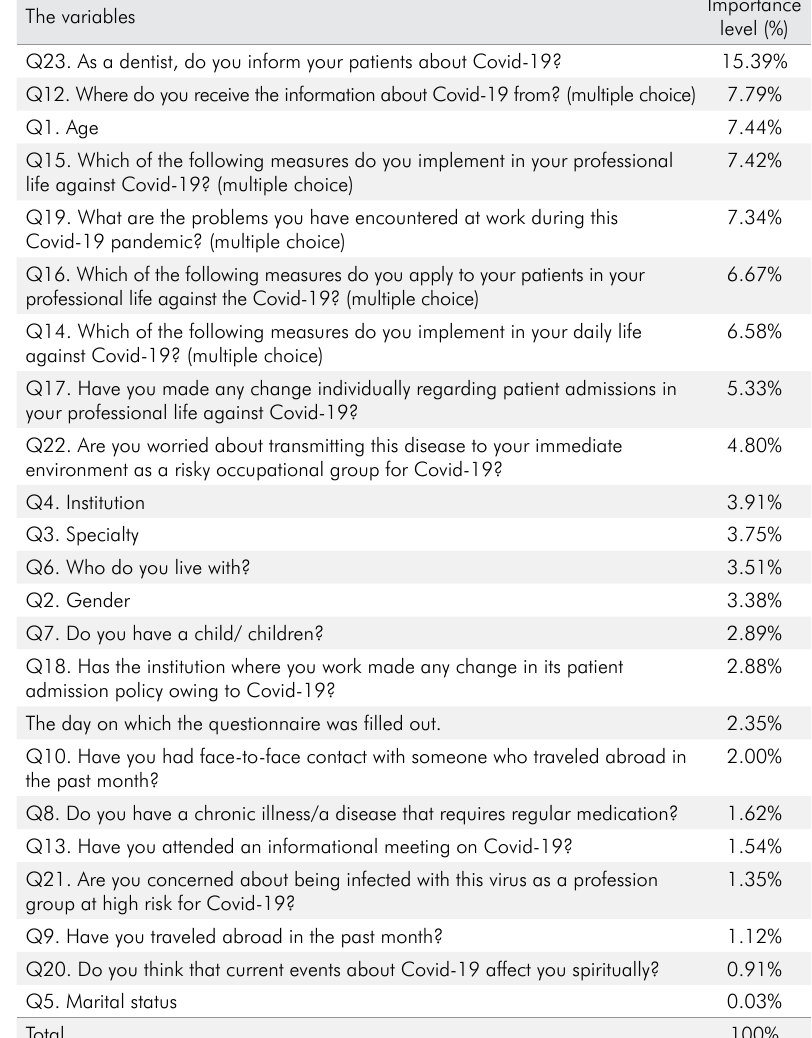
Table 4. The importance levels of the related variables for the dentists’ self-assessed COVID-19 knowledge score according to the MLP ANN